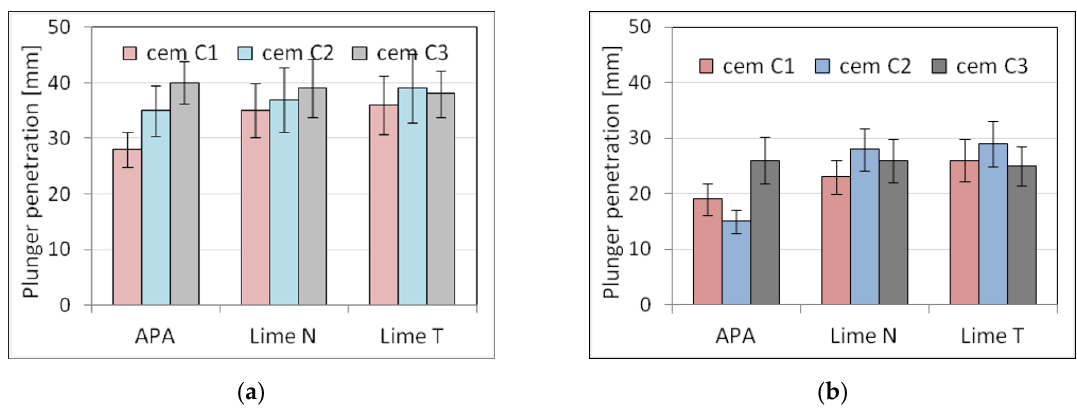
Figure 4 . Influence of the cement type on consistency tested by plunger penetration for ( a ) plaster, ( b ) masonry mortars.